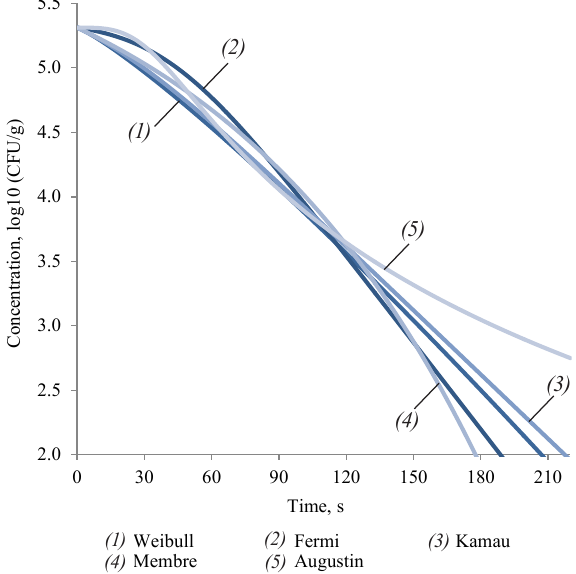
Figure 4 Approximation of the experimental data of microbial survival kinetics of A. acidoterrestris during heat treatment ( t = 105°C) by using nonlinear